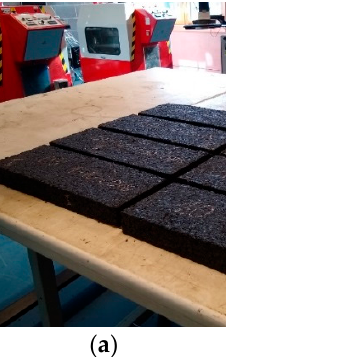
Figure 5. The rutting test: ( a ) the prepared slabs for testing and ( b ) the rut depth measuring procedure.